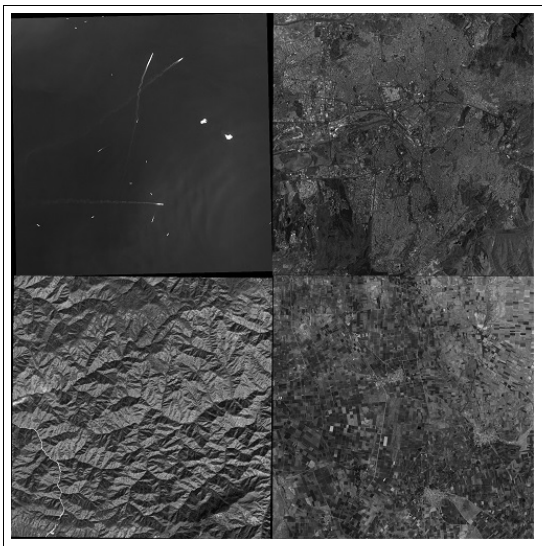
Figure 2: Sample quicklook display of panchromatic SPOT im- ages (upper left: sea, upper right: settlement, lower left: forest, lower right: agriculture) (PAN). c (cid:13) SPOT Image 2015, CNES.